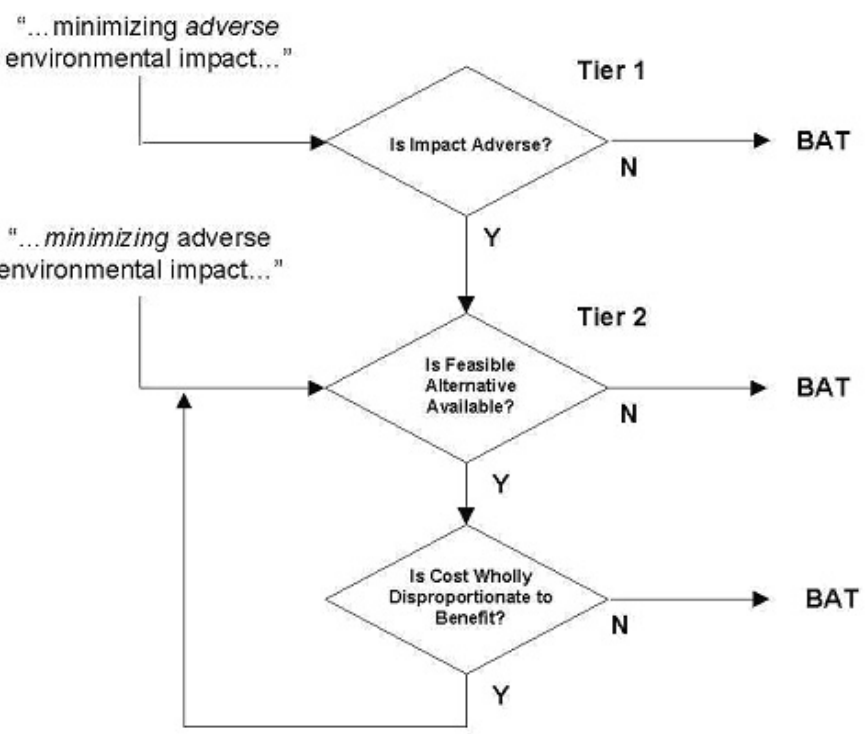
FIGURE 1. Interpretative pathways for the phrase "minimizing adverse environmental impact" in Section 316(b) of the Clean Water Act.